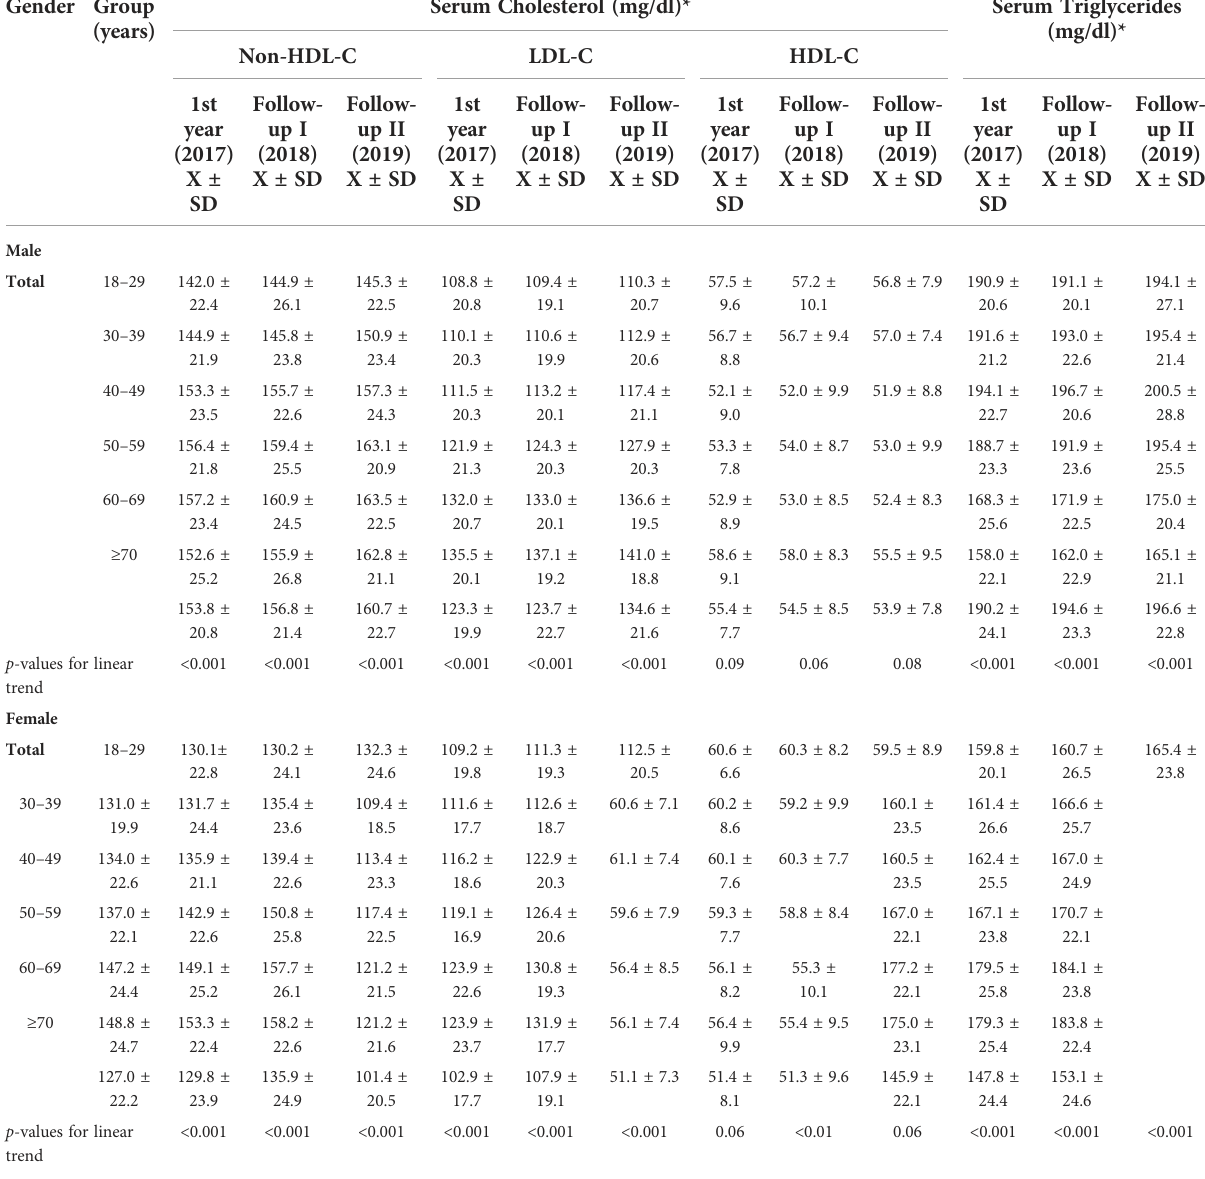
TABLE 2 Means and standard deviations of the serum levels of cholesterol, LDL cholesterol, HDL cholesterol, and triglycerides among adults in East Coast, Fujian, China. Gender